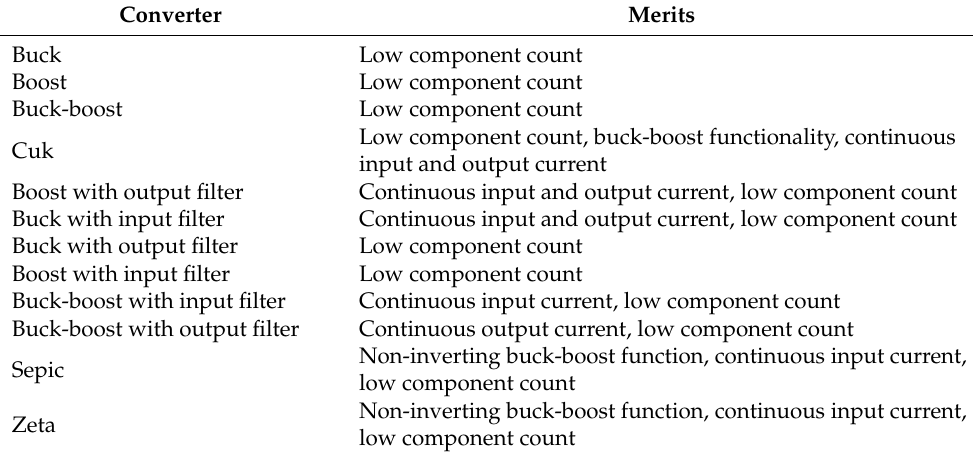
Figure 1. BBBs proposed in [33]. ( a ) a Type 1 BBB, ( b ) variant 1 of a Type 2 BBB, ( c ) Vvariant 2 of a Type 2 BBB, ( d ) a Type 3 BBB, and ( e ) the filter block. Table 1. Converters considered in the